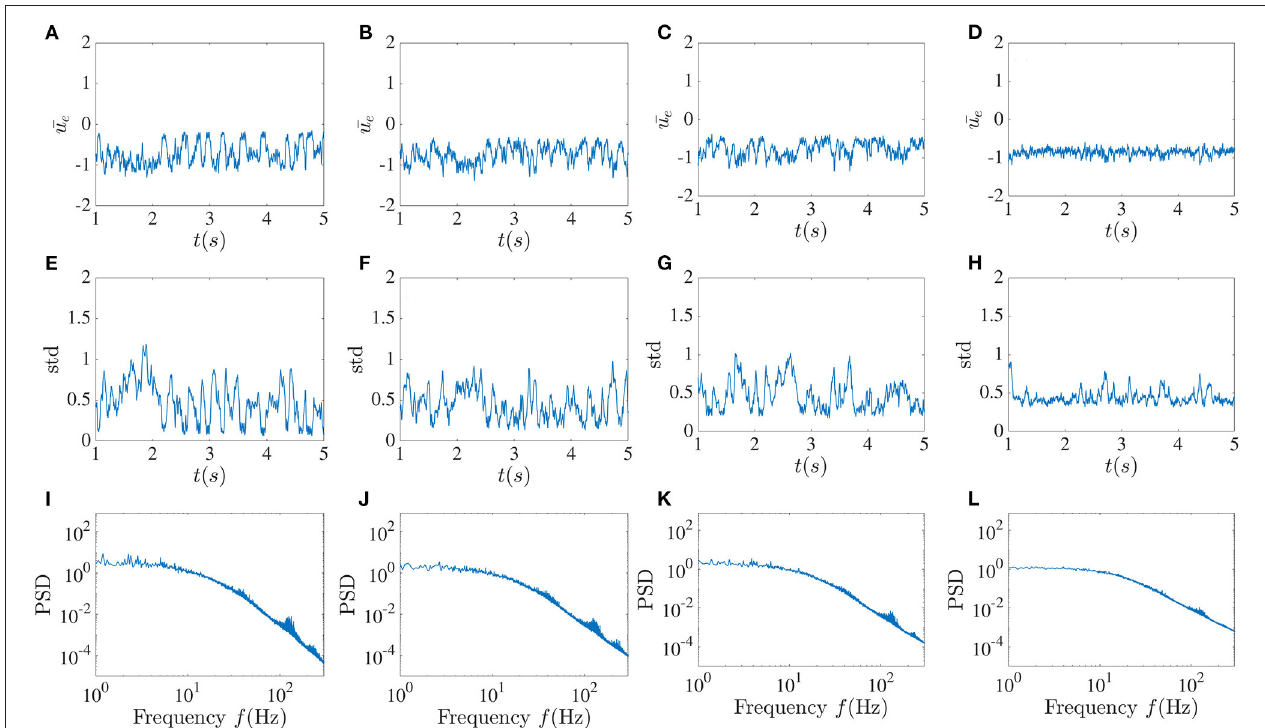
FIGURE 7 | Noise suppresses activity dropouts. Mean activity (A–D) , standard deviation (E–H) , and power spectrum (I–L) averaged over the excitatory sub-network for increasing noise intensity D and fixed global inhibitory feedback with time delay T 5 10 − 4 . The dropouts seen in Figure 4B are no longer seen, and the fluctuations of the standard deviation decrease at higher noise ×